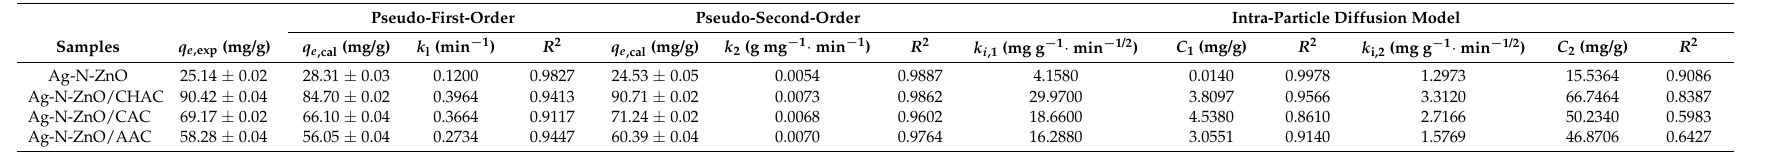
Table 2. Kinetic parameters of MO adsorption onto the four composite